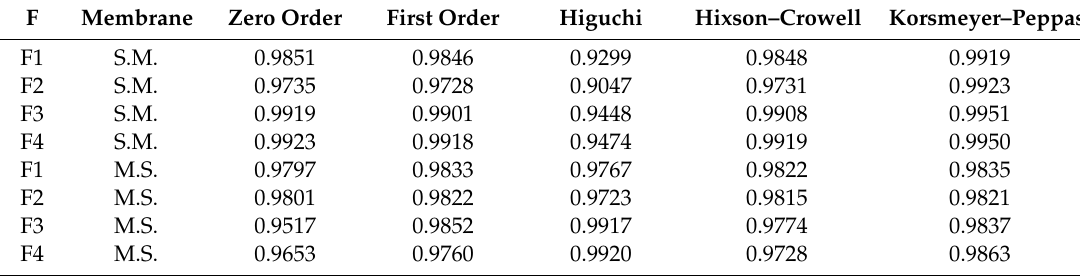
Figure 6. Multivariate analysis of the physicochemical properties of the four HQ formulations and their permeability across mouse skin and Strat-M ® . ( a ) Three-dimensional (3D) scatter plot comparing MV and Jss across mouse skin and Strat-M ® ; ( b ) Correlation loading plot obtained after principal component analysis (PCA). The average value of the following parameters was included for the MVA analysis: mean size in volume (MV), viscosity, span, water content, stability at 25 °C and 40 °C at 30 days expressed as the percentage remaining of HQ, Jss across mouse skin and Strat-M ® . Table 5. Mechanistic release kinetics of HQ from topical formulations (F). Regression coe ffi cient ( R 2 ) values from the permeability data (expressed in % / cm 2 ) through synthetic (S.M.) or natural membranes(M.S.)usingthefollowingkineticequations: zeroorder, firstorder, Higuchi, Hixson–Crowell and